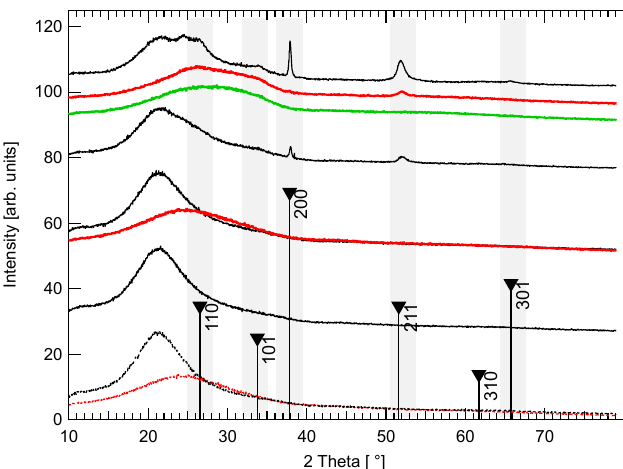
Figure 2. XRD patterns of SnO 2 :Ta films deposited by RF (thin, black lines) and DC (thick, red and green lines) magnetron sputtering in Ar + O 2 atmosphere for di ff erent durations. Deposition parameters: RF: P = 100 W, p = 0.5 Pa, t = 2, 5, 13 and 23 min (from the bottom); DC: P = 25 W, p = 0.5 Pa, t = 5 and 28 min. Film thicknesses increase from about 40 to 450 (500, DC) nm with increasing deposition time. Thick, DC-sputtered films were deposited without (red curve) and with (green curve) three pauses. For comparison, the XRD patterns for the bare substrates quartz (Suprasil, black) and borosilicate glass (D263T, red) are plotted as dotted lines at the bottom. The bars at the bottom of the figure display the di ff raction pattern according to the powder di ff raction file PDF ® _01_070_4175 for SnO 2 -cassiterite (The International Centre for Di ff raction Data, Newton Square, USA).